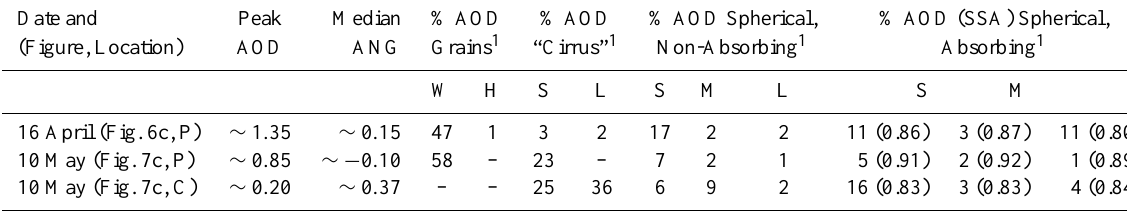
Table 5. Research Retrieval results overview for the downwind